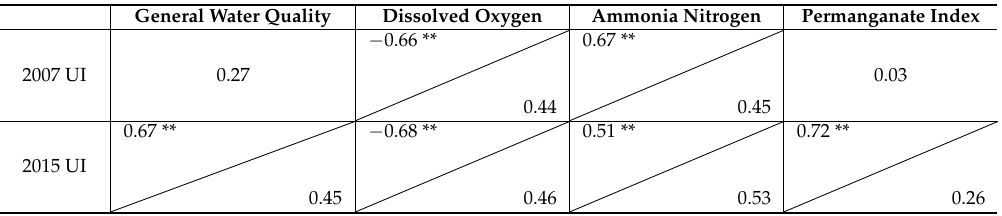
Table 4. Correlation coefficients (Pearson’s r) of I URB and water quality data.